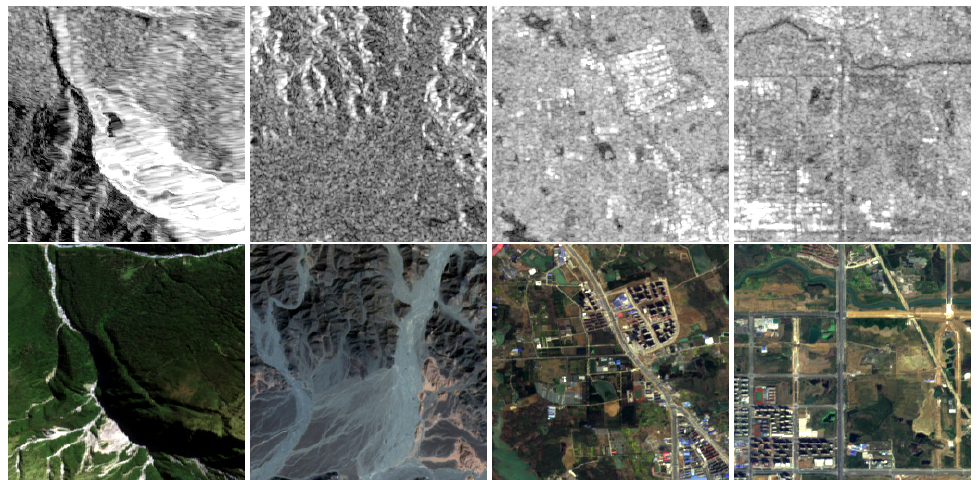
Figure 3. Sample pairs from dataset SEN1-2. The ( top ) row depicts the SAR images from Sentinel-1 and the ( bottom ) row depicts the corresponding EO images from Sentinel-2.